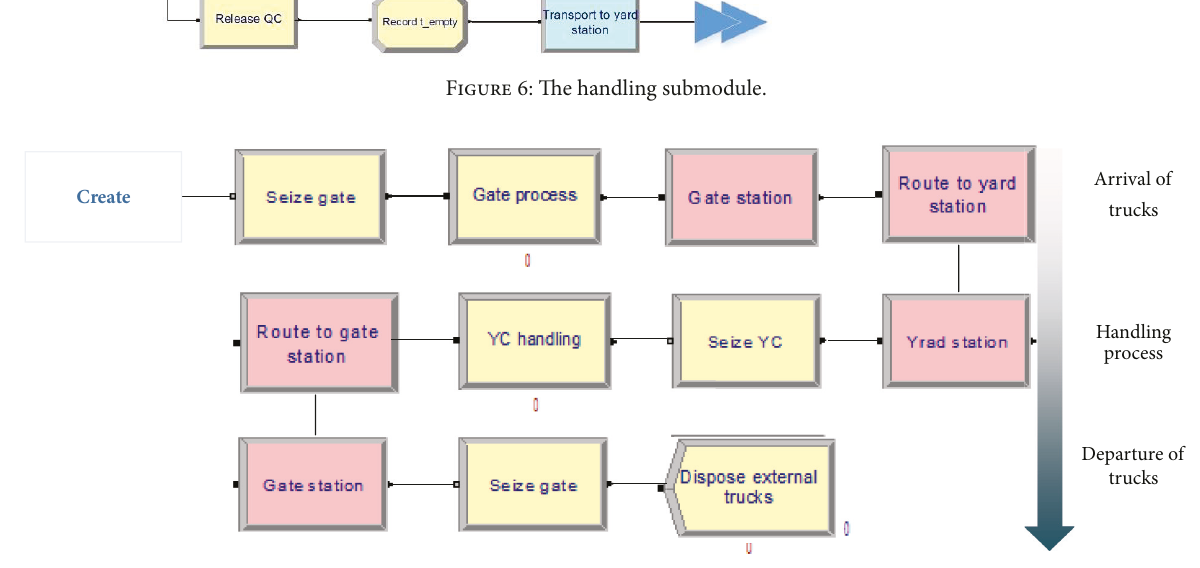
Figure 7: The truck transport submodule.